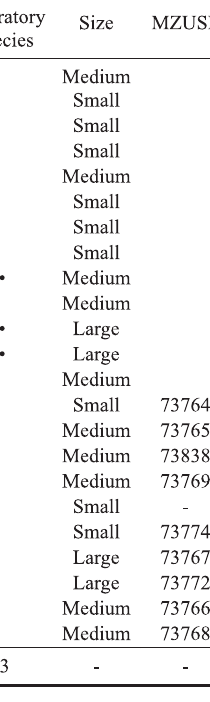
Table 1 . Historical and current fish fauna in Lagoa Santa lake, with some biological attributes of the species listed. Valid names according to Eigenmann (1918), Buckup (1992), Mago-Leccia (1994), Britski (2001). Size: small = adults smaller than 15 cm; medium = between 15 and 30 cm; large = larger than 30 cm total length. MZUSP: catalog numbers of voucher